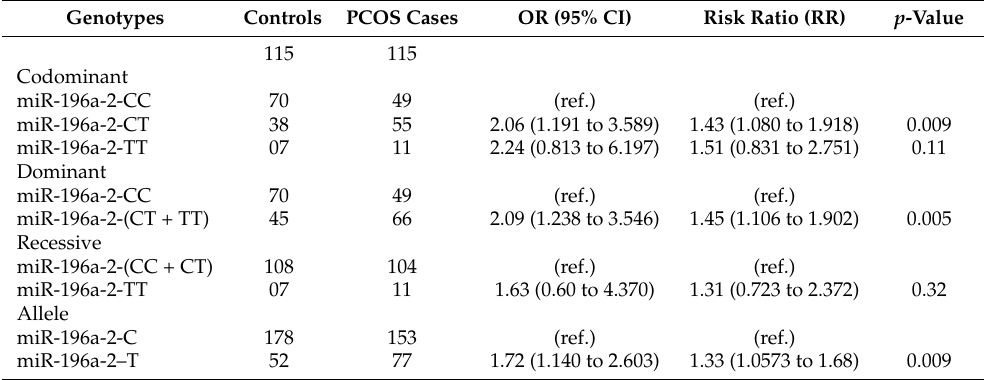
Table 10. Association of miR-196a-2 rs11614913 C > T gene variation in PCOS cases and controls.